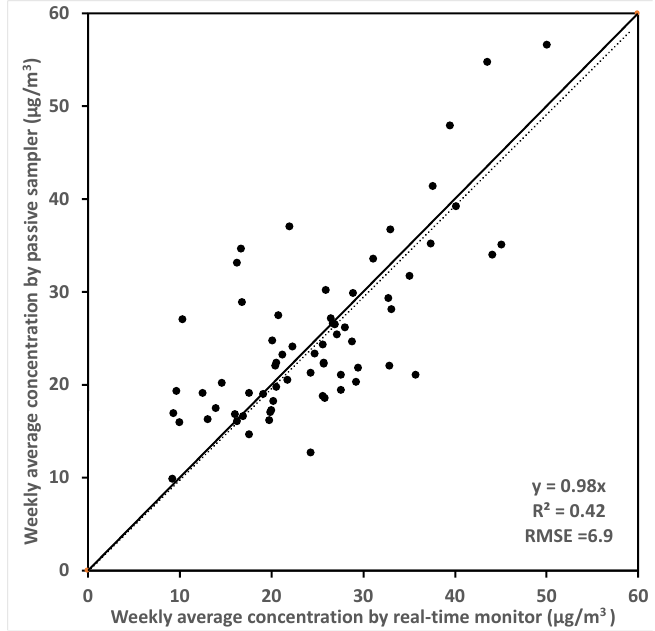
Figure 1. Weekly averaged formaldehyde concentrations measured by passive samplers and real-time monitors in 66 test houses, concentrations were averaged from both master bedroom and living room.